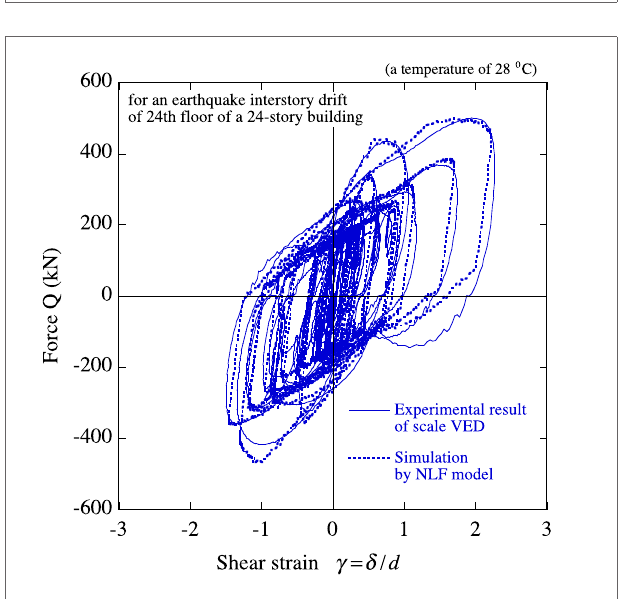
FIGURE 11 | Resisting force characteristics of test VE material and VED .